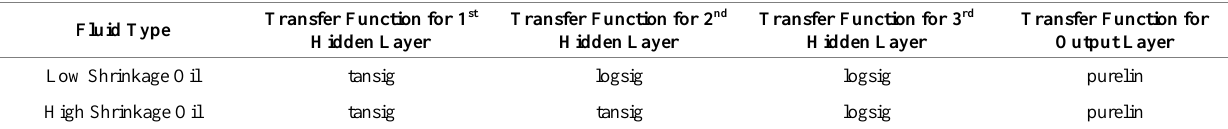
Table 10. Transfer function used for design of Neuro-Simulation Tool